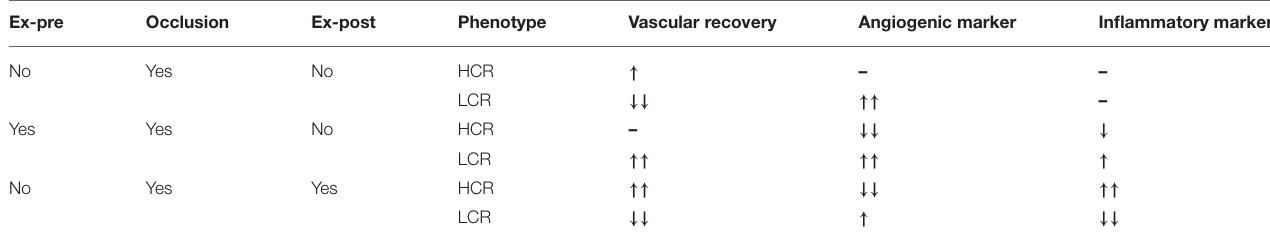
TABLE 2 | The influence of exercise before and after occlusion on vascular recovery, angiogenesis and inflammation in the HCR and LCR phenotypes (74).